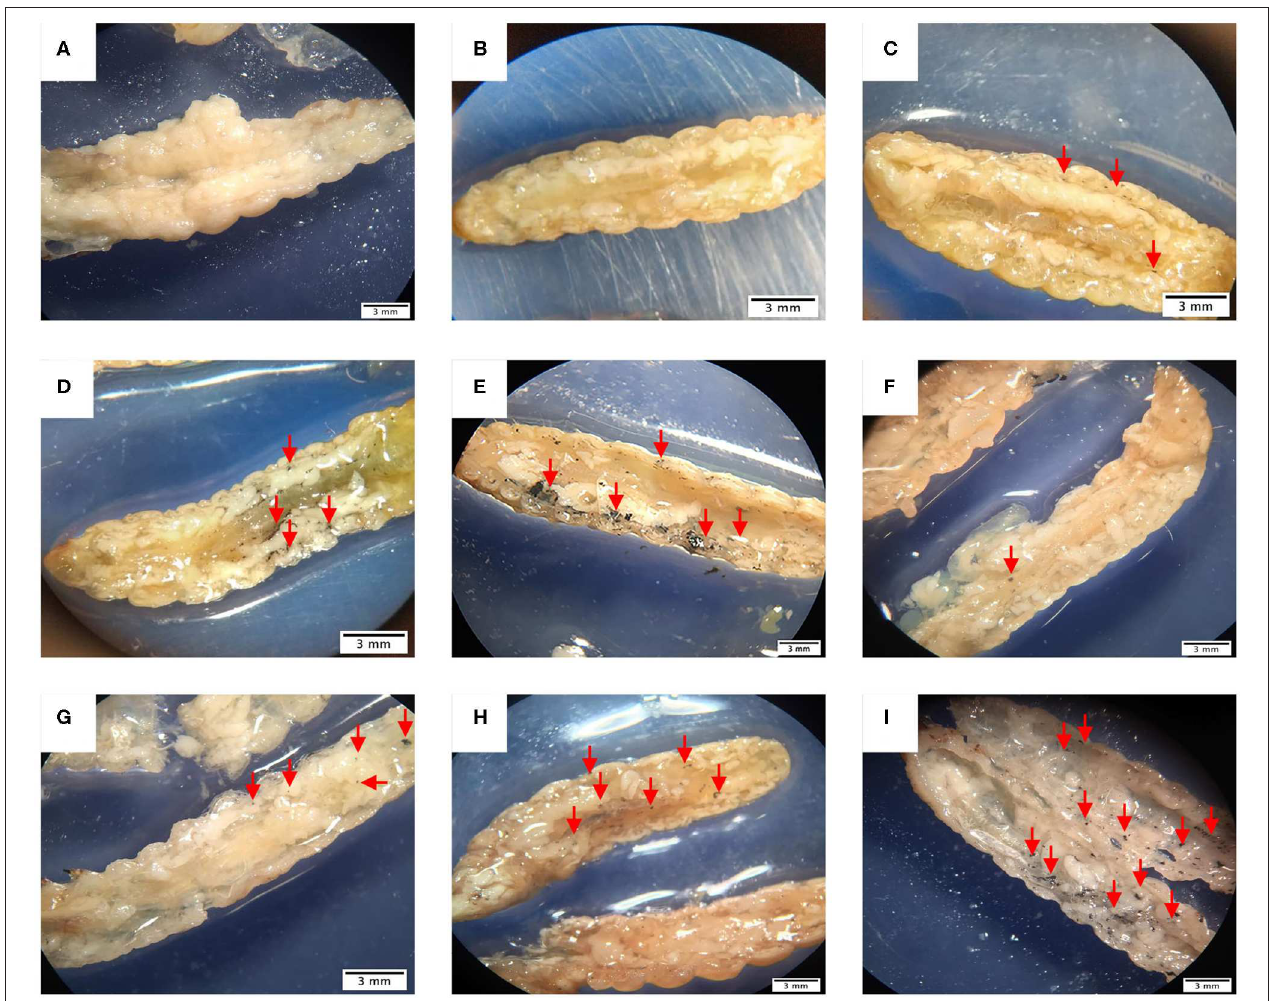
FIGURE 7 | G. mellonella larvae half sectioned under the stereoscope. (A) Control larva showing no presence of nodules, in contrast (B–E) larvae infected with M. furfur displaying nodule formation close to the cuticle and lesser dissemination than (F–I) larvae infected with M. pachydermatis . In both cases, larvae present different quantity of nodules depending on the inoculum concentration, as the concentration increases, the number of nodules arise. Larvae infected with M. furfur (B) 1.5 × 10 6 CFU/mL inoculum concentration, (C) 1.5 × 10 7 CFU/mL inoculum concentration, (D) 1.5 × 10 8 CFU/mL inoculum concentration, and (E) 1.5 × 10 9 CFU/mL inoculum concentration. Larvae infected with M. pachydermatis (F) 1.5 × 10 6 CFU/mL inoculum concentration, (G) 1.5 × 10 7 CFU/mL inoculum concentration, (H) 1.5 × 10 8 CFU/mL inoculum concentration, and (I) 1.5 × 10 9 CFU/mL inoculum concentration. Red arrows show the position of